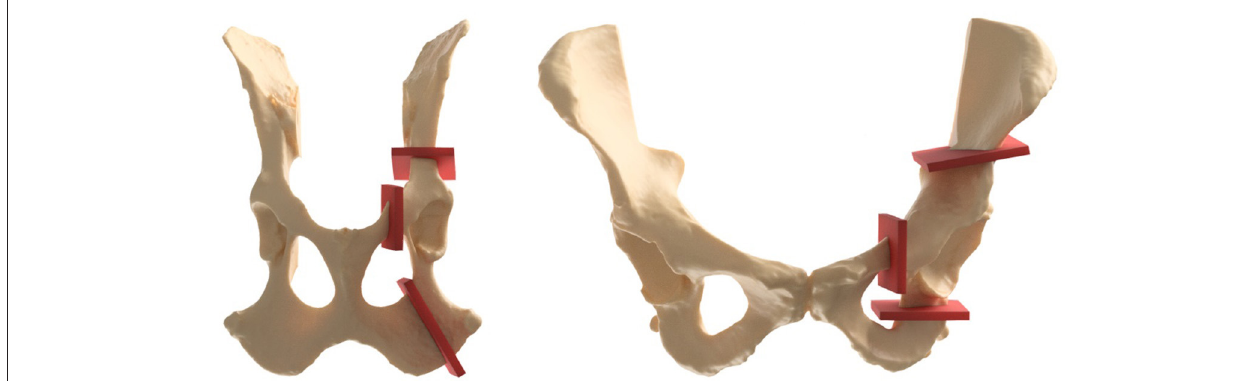
FIGURE 5 | Canine left and human right triple pelvic osteotomies (purple planes) are made in the pubic, ischial and iliac bones and subsequently the acetabulum is rotated ventrally (dogs) or anteriorly (humans) to improve femoral head coverage and increase the load bearing area.